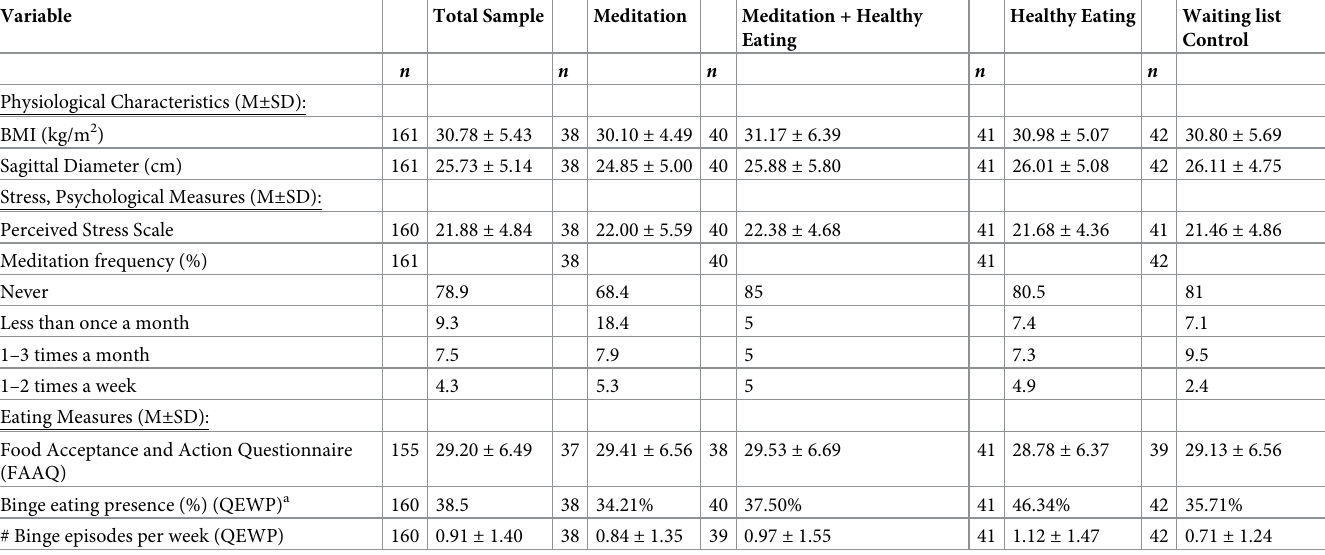
Table 2. Baseline health characteristics.